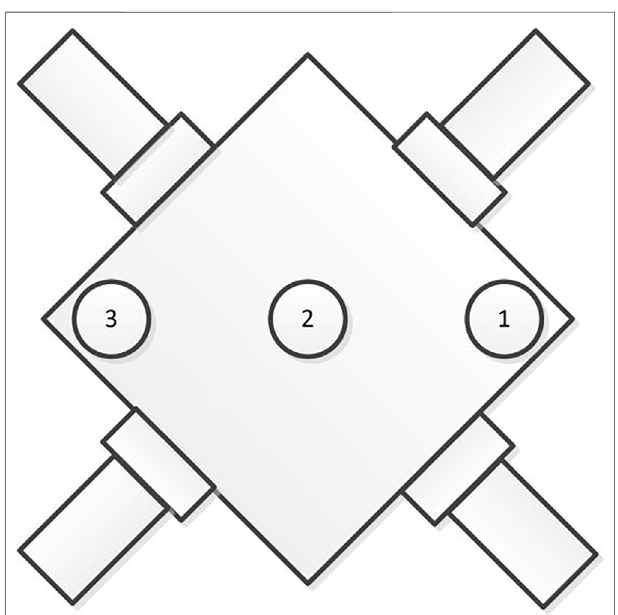
FIGURE 3 | Plane distribution of Am-Li sources.